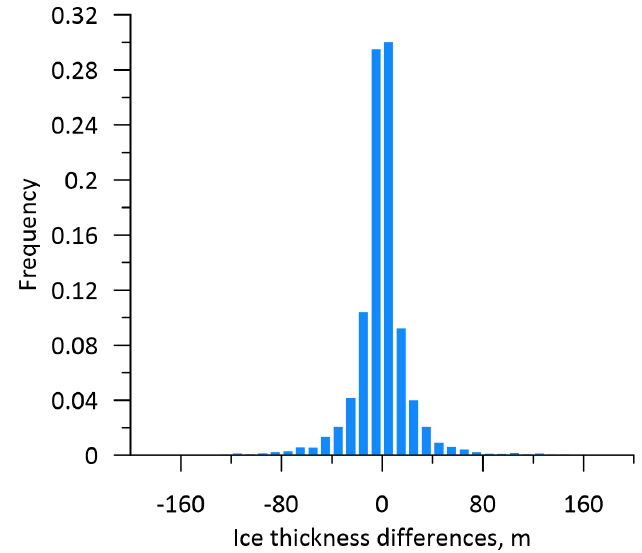
Figure 4. Histogram of the ice thickness errors in the cross-overs of the RES